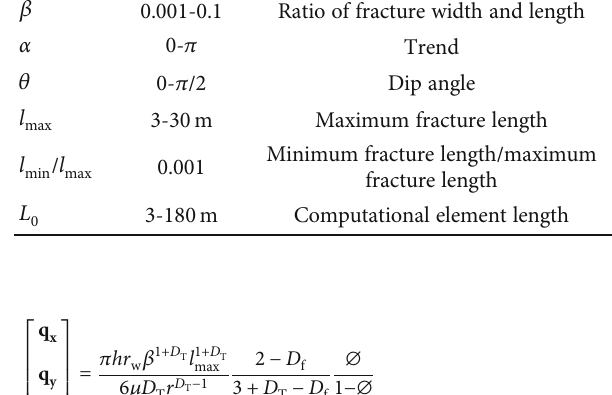
and D ( β = 0 : 01 , θ = π /6 , xx T